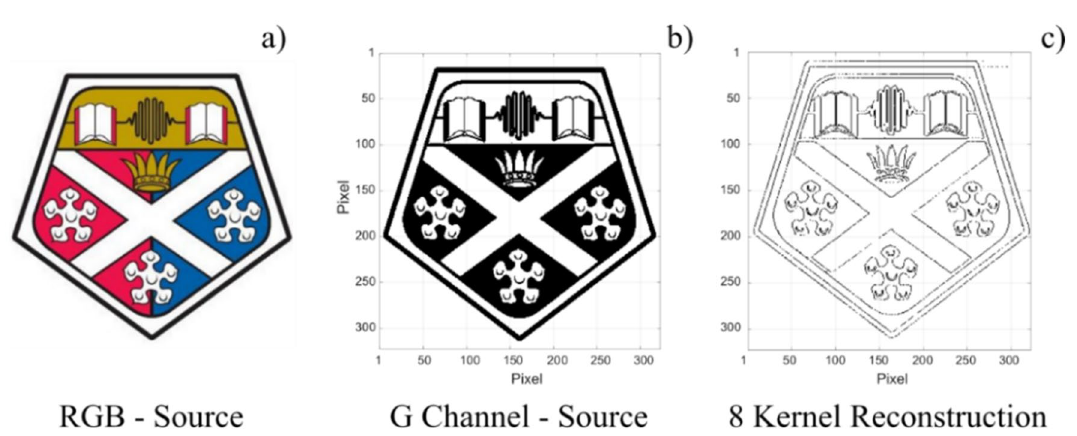
Figure 3. Experimental edge detection of a complex, large size image with the VCSEL neuron. The 323 × 323 University of Strathclyde (UoS) crest source image (a) and its green (G-) colour channel component (b) . The image is sequentially operated on by 8 2 × 2 kernels producing the reconstruction with all edge-features detected (c)